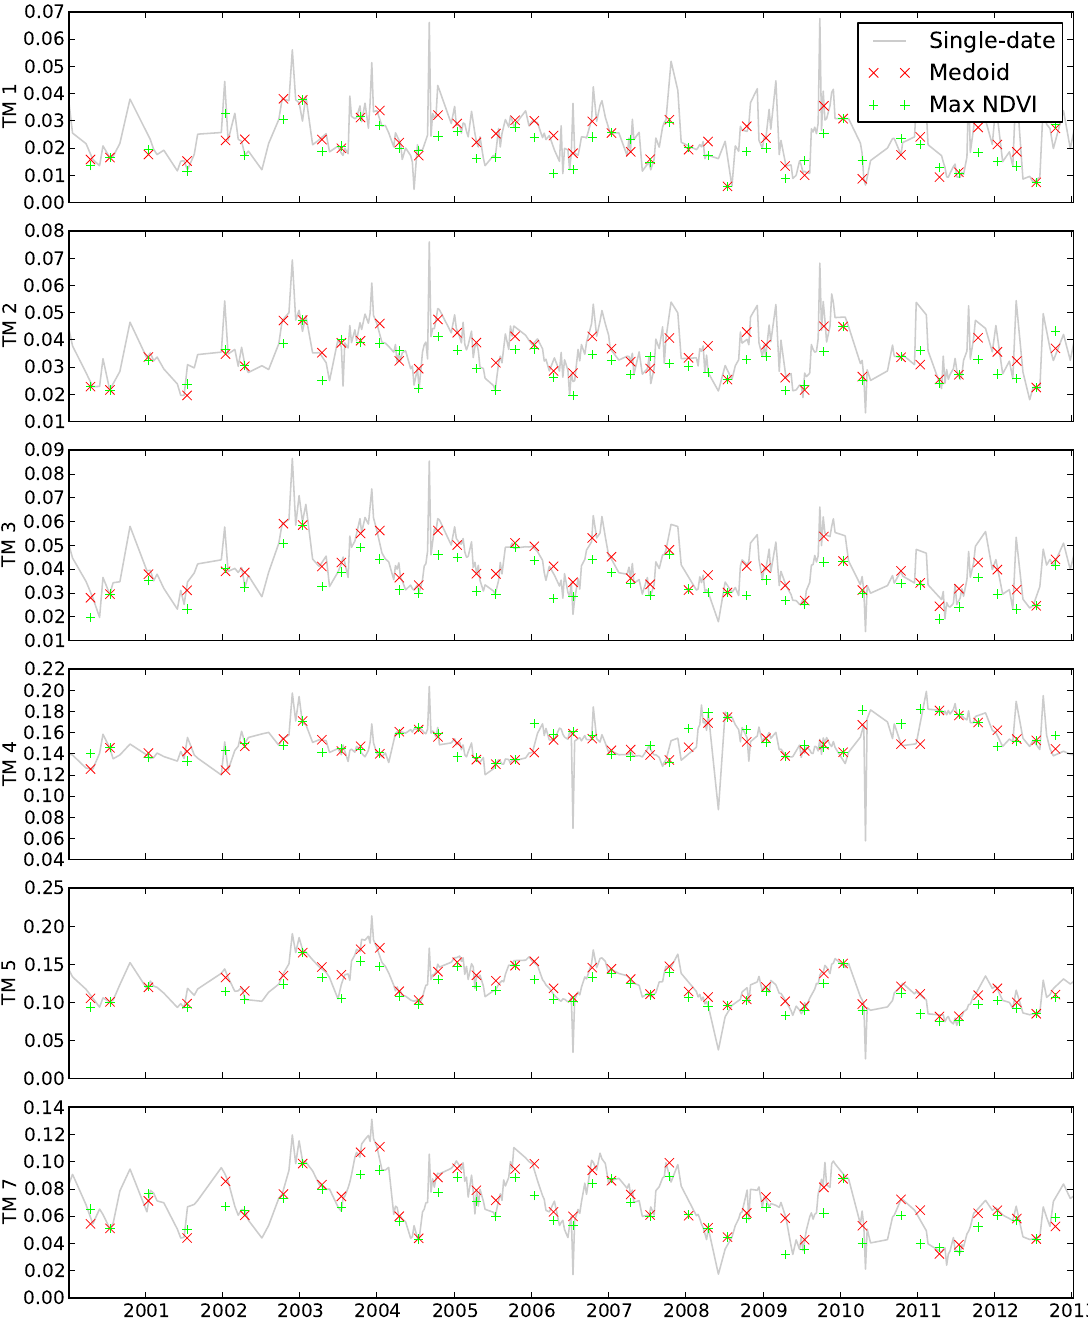
Figure 4. Time series of reflectance for all Landsat TM/ETM+ reflective bands, for the forested example pixel. Seasonal values are marked as crosses. The green crosses are the seasonal reflectance values as selected by the maximum NDVI method, while the red crosses are the seasonal reflectance values selected using the